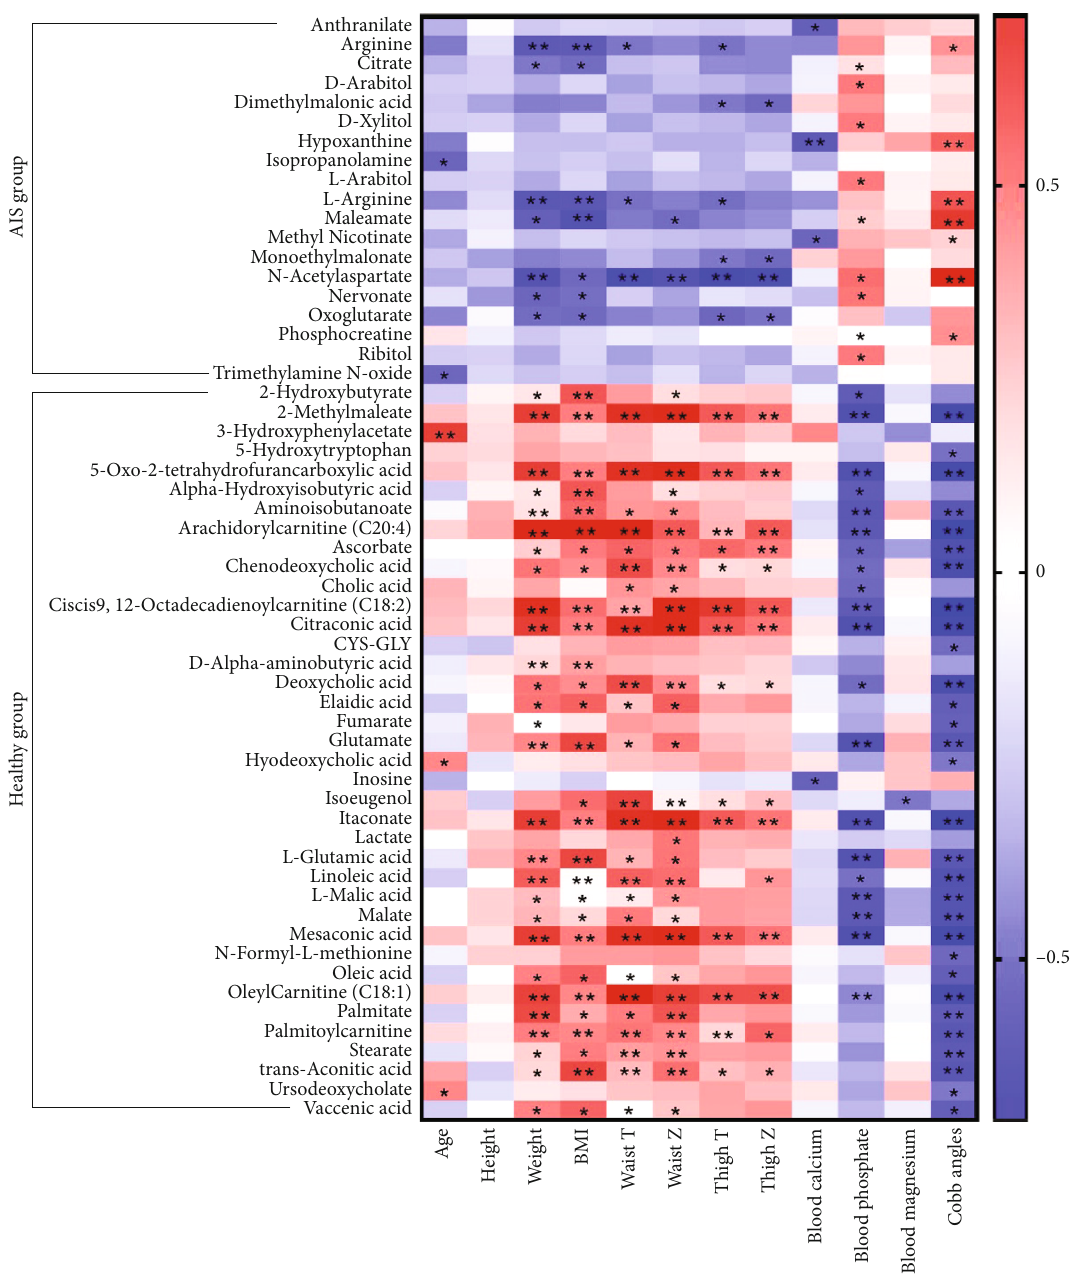
Figure 4: Correlation analysis of metabolites and clinical